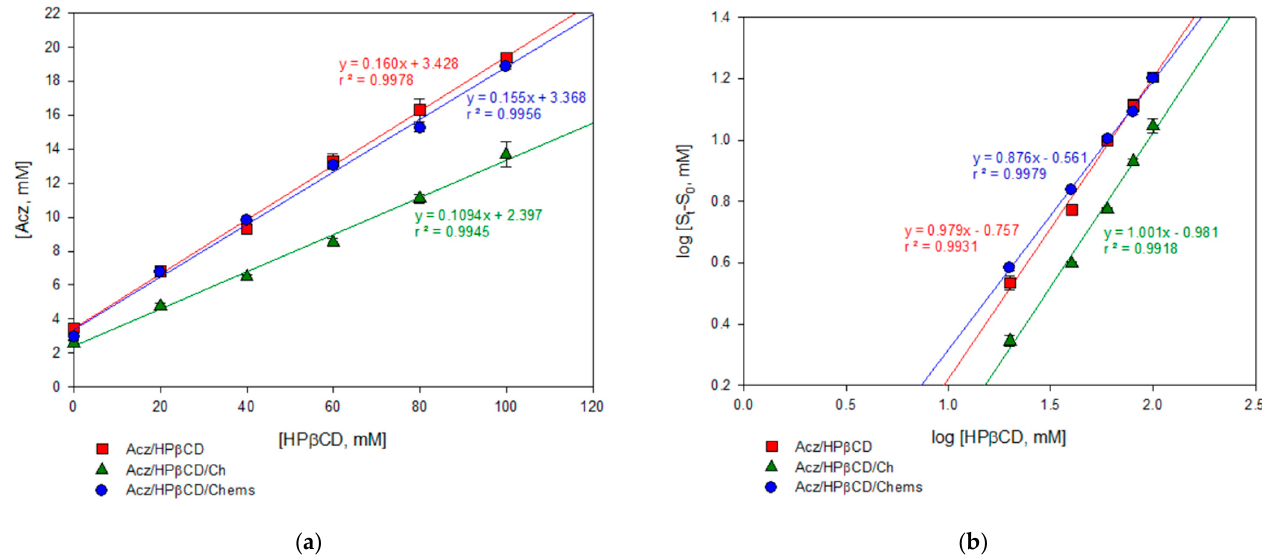
Figure 1. Solubility phase profiles of acetazolamide–(2-hydroxy)propyl- β -cyclodextrin alone (Acz/HP β CD) and in the presence of cholesterol (Acz/HP β CD/Ch) or cholesteryl hemisuccinate (Acz/HP β CD/Chems): ( a ) concentration of Acz solubilized vs. HP β CD concentration; ( b ) log–log plotting to calculate Kc.